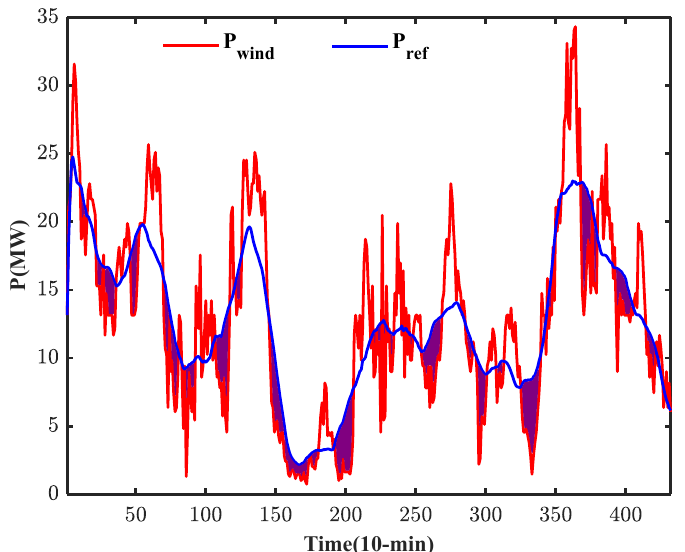
Figure 13. Sample of actual and smoothed wind power.